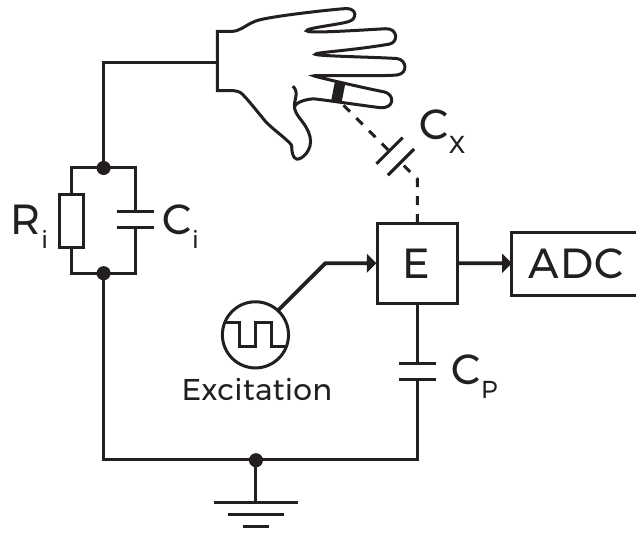
Figure 2. Lumped circuit model of measuring capacitance C x at a single electrode E